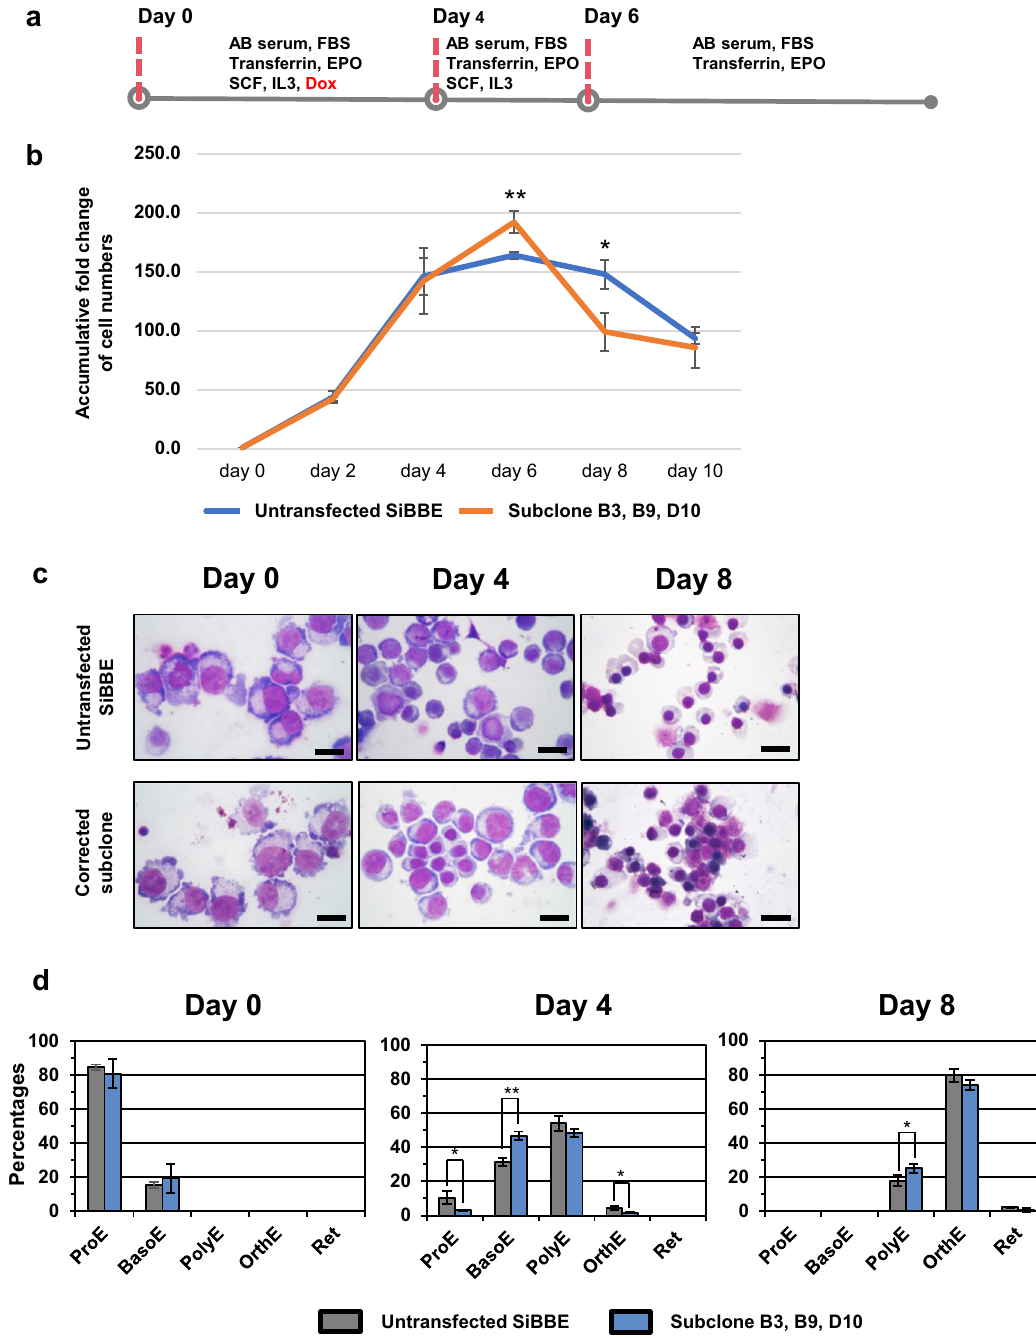
Figure 2. Erythroid differentiation of the HbE-corrected SiBBE cells. ( a ) Schematic diagram of the erythroid differentiation protocol used in this study. ( b ) Accumulative fold expansion during erythroid differentiation of the HbE-corrected SiBBE subclones (B3, B9 and D10) and the untransfected SiBBE cells. ( c ) The differentiated HbE-corrected SiBBE subclone and untransfected SiBBE cells on days 0, 4 and 8 stained with Leishman reagent and analysed by a light microscope; representative images of three independent cultures (scale bar = 20 µm). ( d ) Percentage of erythroid cell types on days 0, 4 and 8 during erythroid differentiation of the HbE-corrected SiBBE subclones and the untransfected SiBBE cells (mean ± SD, n = 3). ProE = proerythroblast; BasoE = basophilic erythroblast; PolyE = polychromatic erythroblast; OrthE = orthochromatic erythroblast; Ret = reticulocyte. * p value < 0.05, ** p value < 0.01, two-tailed